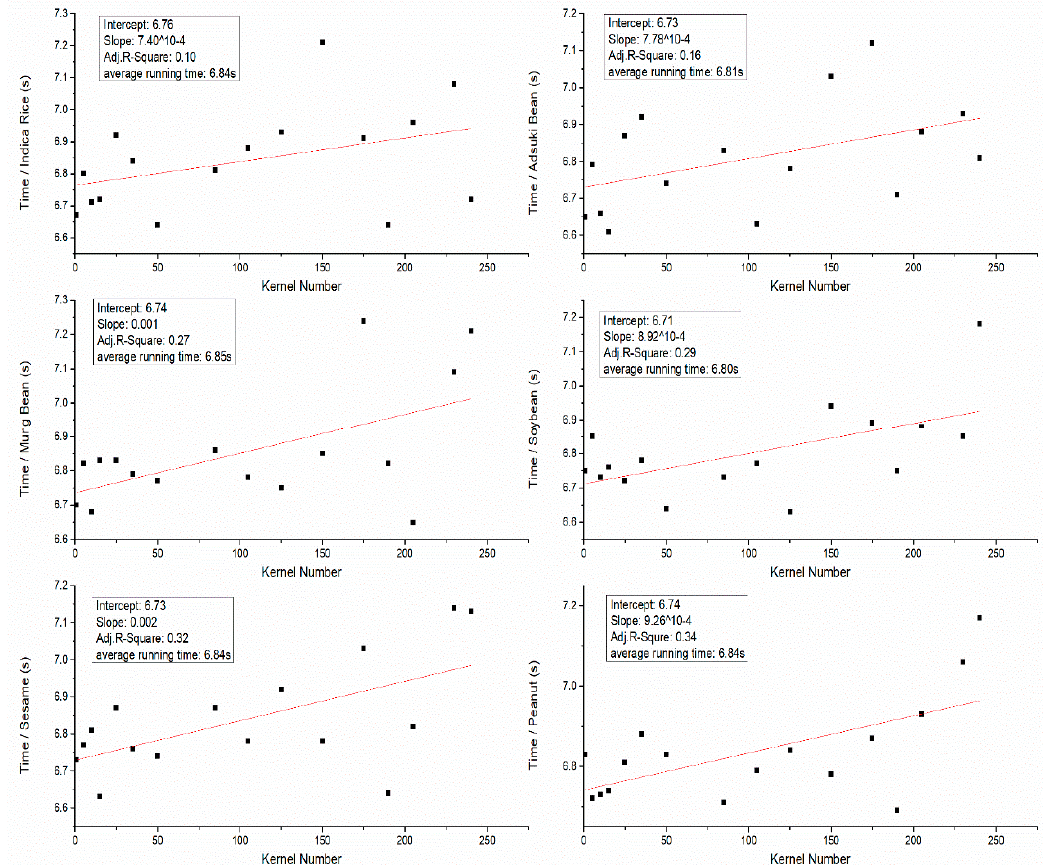
Figure 10. The relationship between running time and kernel number on the same device.